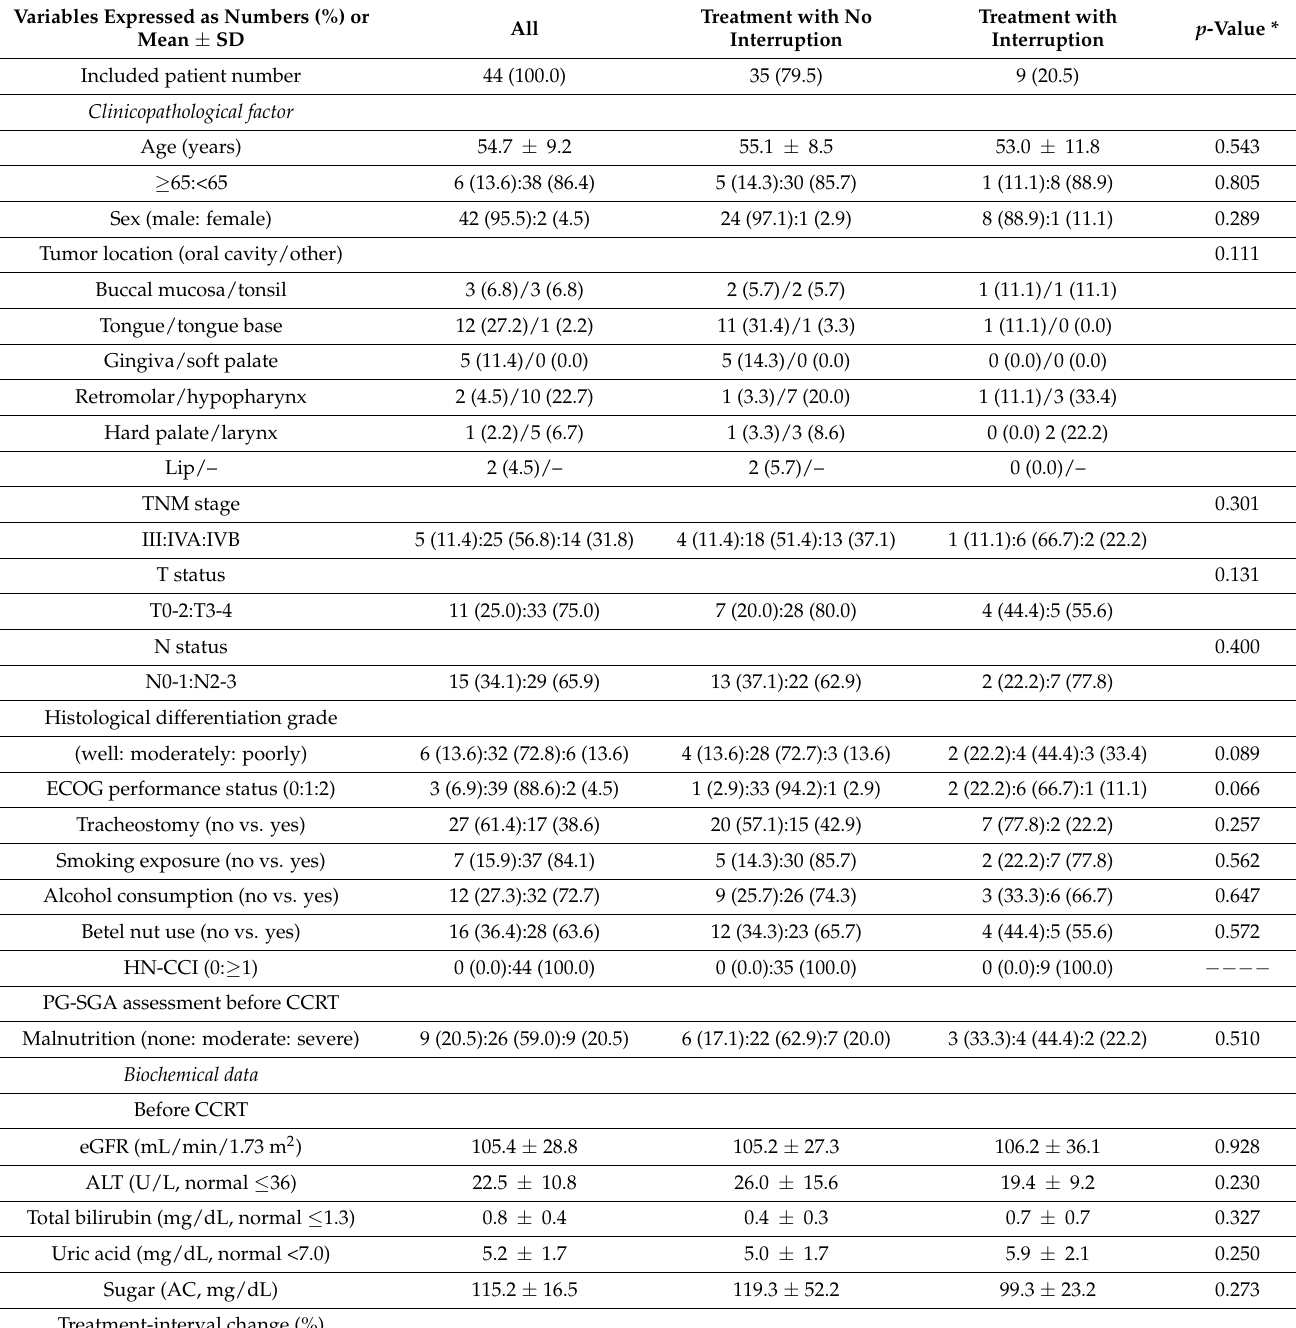
Table 1. Clinicopathological variables, biochemical and nutrition–inflammation data, anthropometric and body composition characteristics, serum HLOP metabolites, and treatment-related factors of 44 patients with LAHNSCC completing the CCRT course, stratified by treatment